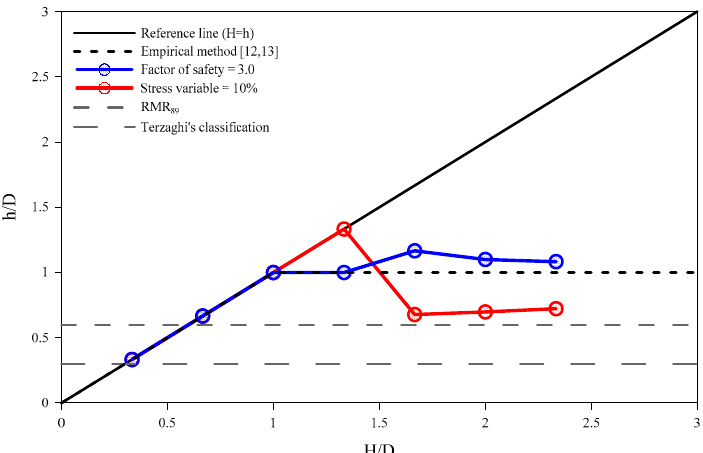
Figure 13. Relation between H/D and h/D for rock mass class IV considering the factor of safety and stress stress variable.